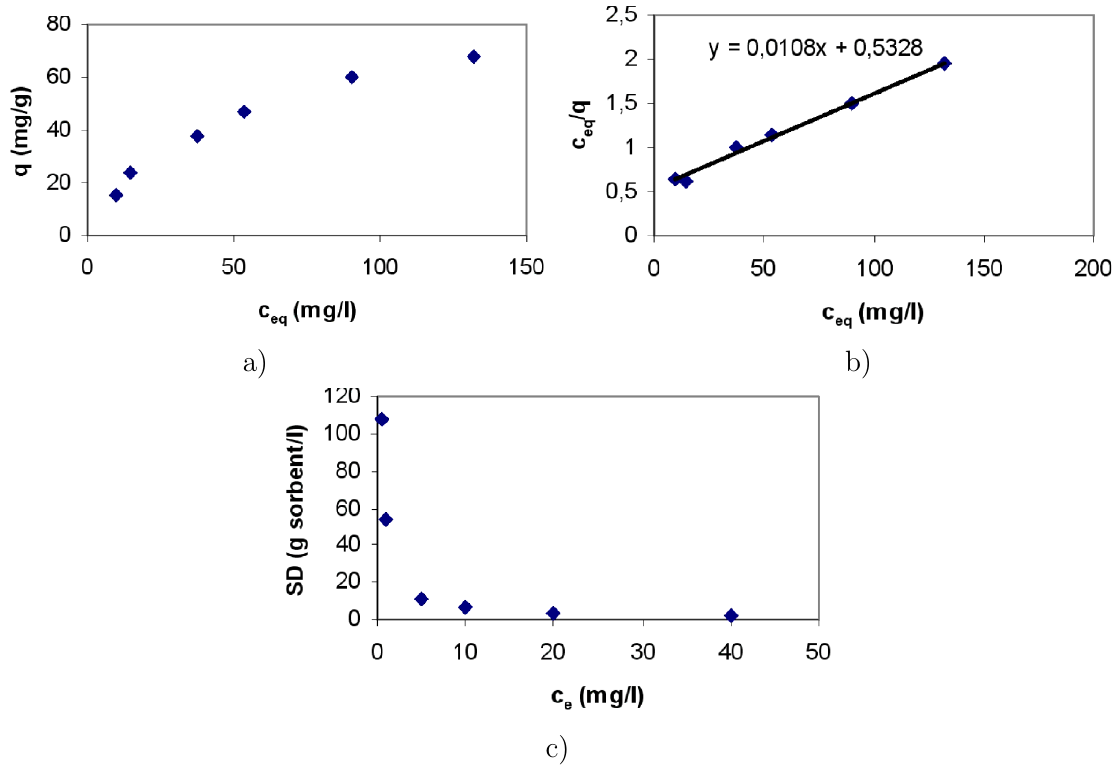
Fig. 7 Lead biosorption isotherm at pH 6 on the mycelia sample B (a), linearised Langmuir isotherm (b), sorbent dosages for di¬erent › nal concentrations